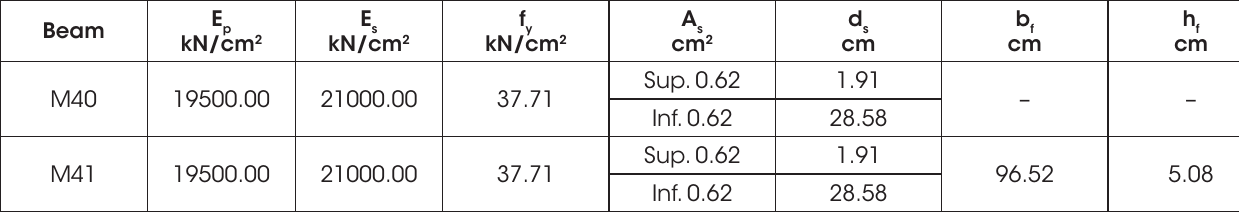
Additional data for the beams tested by MATTOCK [8]